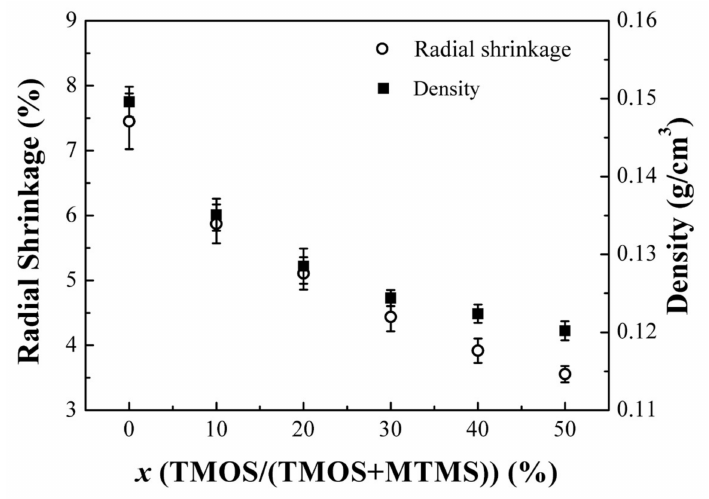
Figure 1. The radial shrinkage and density of aerogels with varied amount of